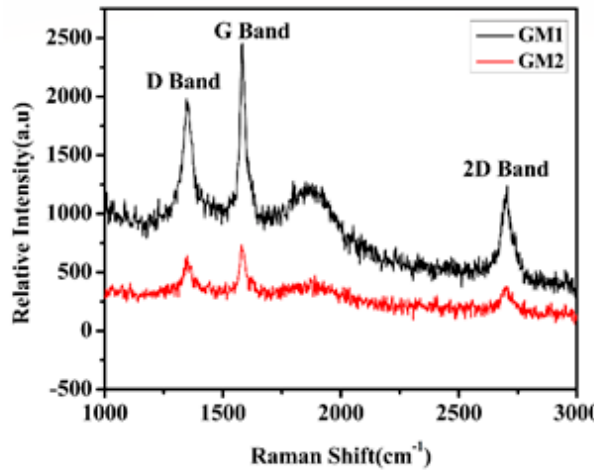
Figure 5. Raman spectra of GM1 and GM2 (excitation wavelength. 532 nm).